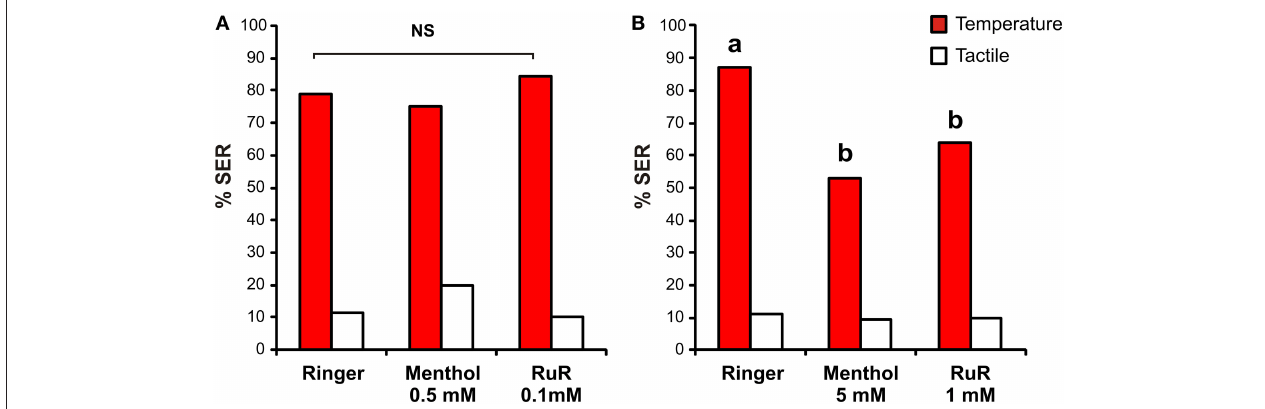
FIGURE 6 | Impact of HsTRPA inhibitors on SER to thermal stimulations. Bees were injected in the median ocellus with menthol, ruthenium red (RuR) or Ringer as control. Sting extensions were recorded in response to 1 sec thermal stimulation (65 ◦ C; red) and tactile stimulation (white). (A) At low concentration (0.5mM menthol and 0.1mM RuR), no effect of the inhibitors appeared. (B) At 10 times higher concentrations (5mM menthol and 1mM RuR) both drugs significantly inhibited SER responses to heat. Different letters indicate significant differences among groups ( p < α corr = 0.025 ).